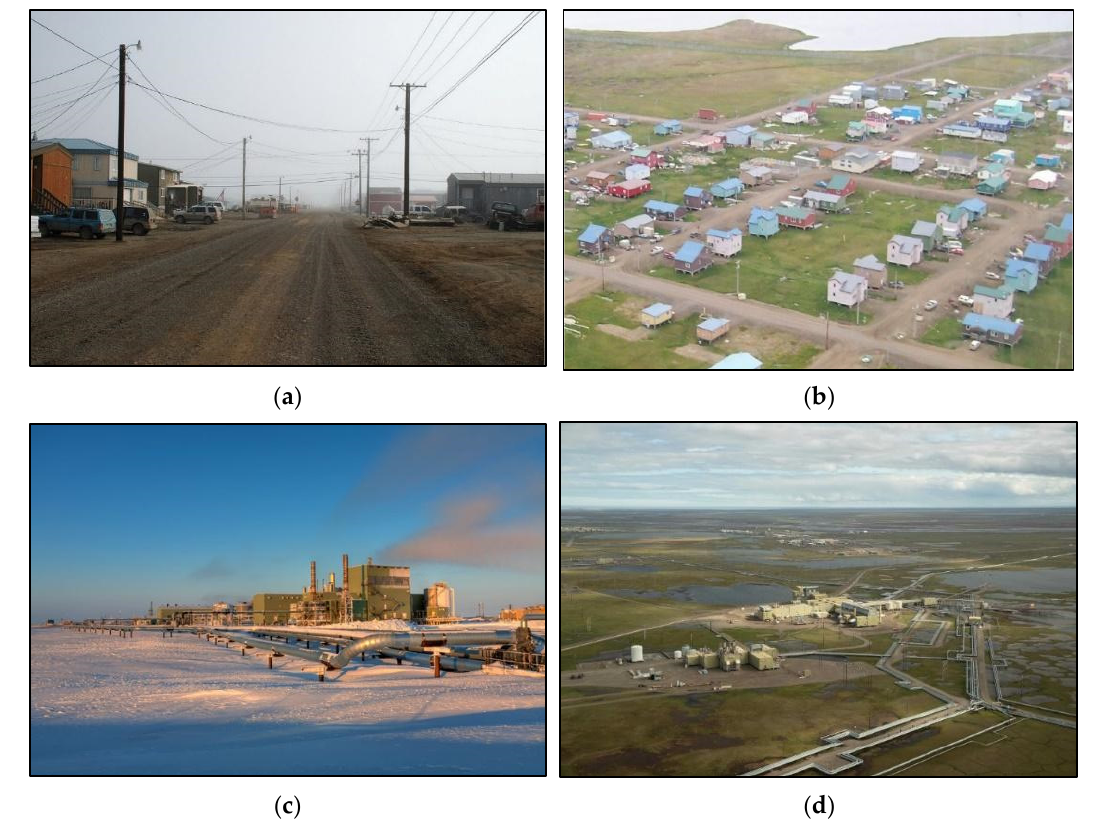
Figure 2. ( a ) Unpaved road in Utqiagvik surrounded by residential buildings (photo credits: Andrei Taranchenko). ( b ) Residential neighborhood in Utqiagvik (photo credits: Native Village of Utqiagvik). ( c ) Gathering Center 1 on Prudhoe Bay oil field (photo credits: Lucas Payne). ( d ) Flow Station 1 on Prudhoe Bay oil field (photo credits: Judy Patrick). Table 2. General characteristics of VHSR commercial satellite image scenes used to train and test the U-Net